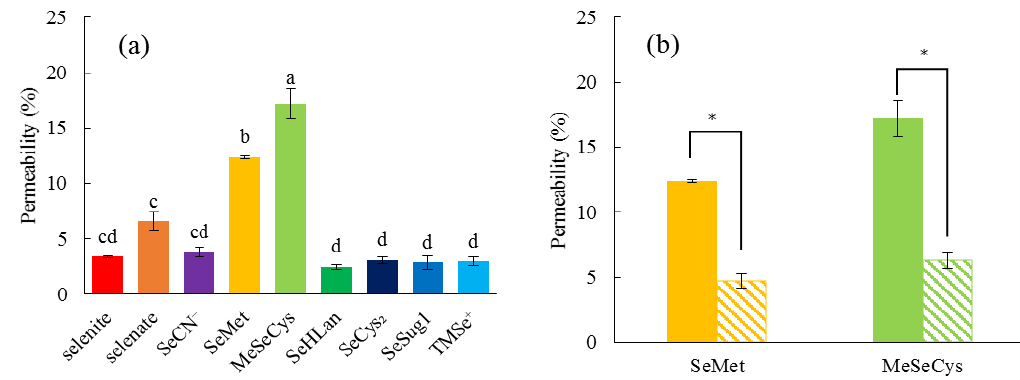
Figure 3. Permeability from the apical side to the basolateral side of Caco-2 cells. The permeability of the nine bioselenocompounds was compared ( a ). A 500 µ L aliquot of fresh medium containing 1 µ g Se/mL of each bioselenocompound was poured into the insert and the medium in the lower chamber was collected after 90 min. Values and bars are means ± SD for 3 wells. Statistical analysis was performed by the Tukey test. The level of significance was set at p < 0.05, and values that have a different letter are significantly different. The effects of Met on the permeability of SeMet and MeSeCys were evaluated ( b ). Hatched and solid bars represent with and without 10 mM Met, respectively. Points and bars are means ± SD for 3 wells. Statistical analysis include the one-way analysis of variance followed by the Student’s t -test. The level of significance was set at p < 0.05, and is indicated by an asterisk (*).